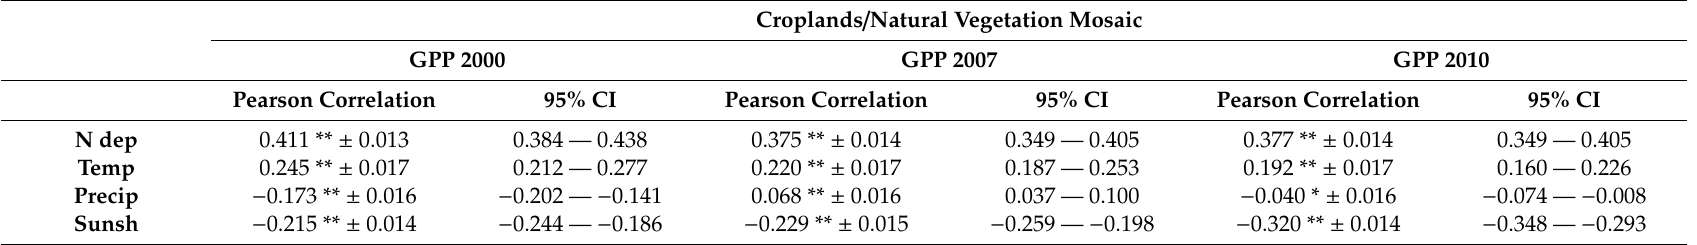
Table A3. Pearson’s correlation between GPP: Gross primary productivity and N dep: N deposition, Temp: Temperature, Precip: Precipitation, and Sunsh: Sunshine, based on a bootstrap of 1000 samples per land cover class and year. * Statistically significant p < 0.05 ** Statistically significant p <